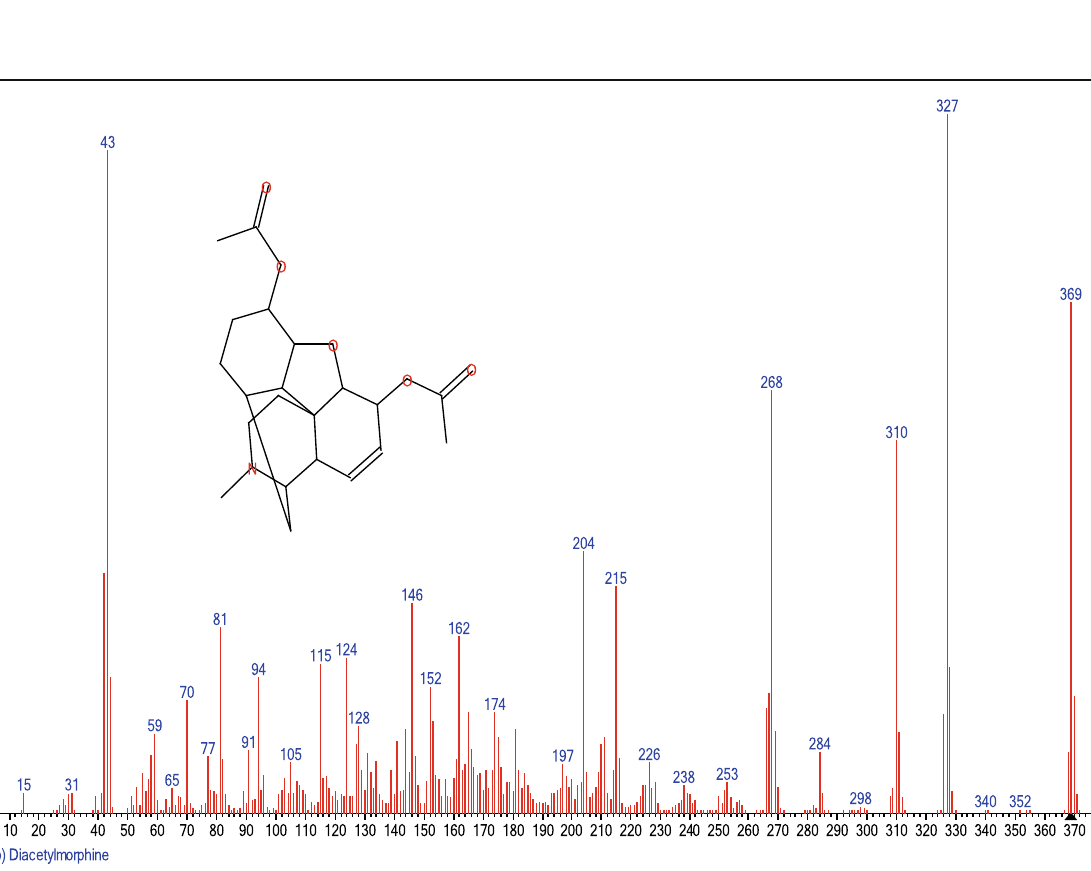
Fig. 4 Mass spectral characteristics of Morphine in the third instar larvae of L. cuprina after